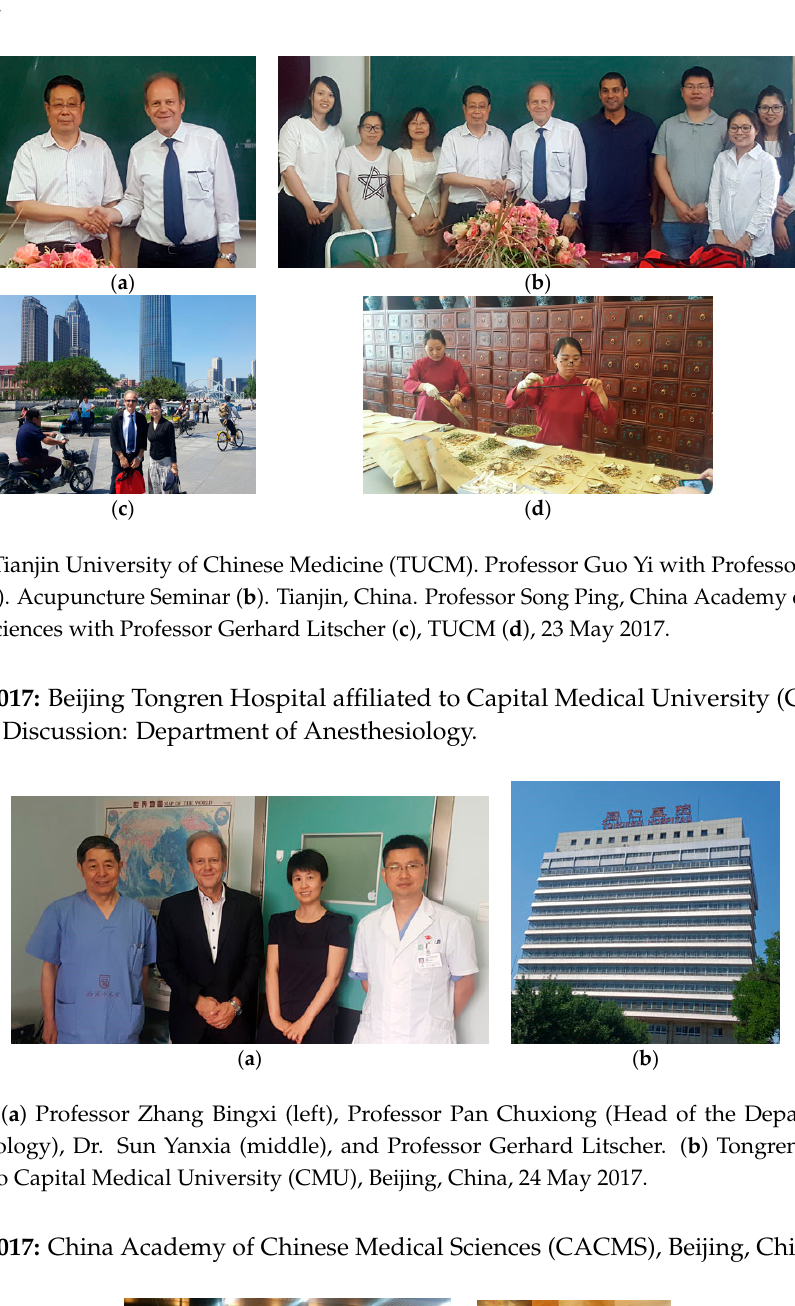
Figure 10. Professor Gerhard Litscher with Professor Jing Xianghong, Director of the Institute of Acupuncture and Moxibustion, China Academy of Chinese Medical Sciences (CACMS) ( a ) and Dr. Wang Guangjun, CACMS; ( b ) Beijing, China, 24 May 2017.